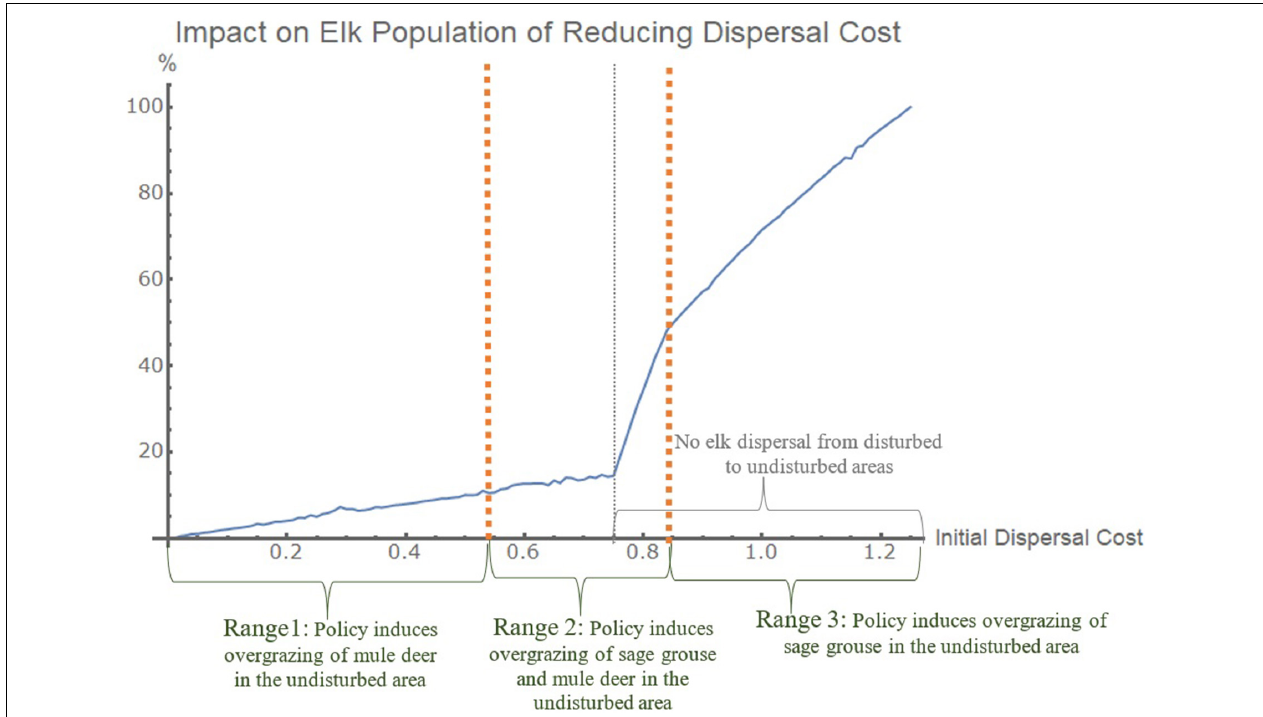
FIGURE 5 | Conservation actions that reduce the dispersal cost of all species (Complex Model, target Elk). The graph shows the impact of optimal conservation budget allocations on elk populations (vertical axis) for the complex model across different initial dispersal costs (horizontal axis). The graphs are normalized such that 100% is the highest possible impact and 0% is the lowest possible impact for this dispersal cost conservation policy. The x -axis is the initial dispersal cost but the response of the elk population is to the optimal policy reduction in those dispersal costs from that initial dispersal